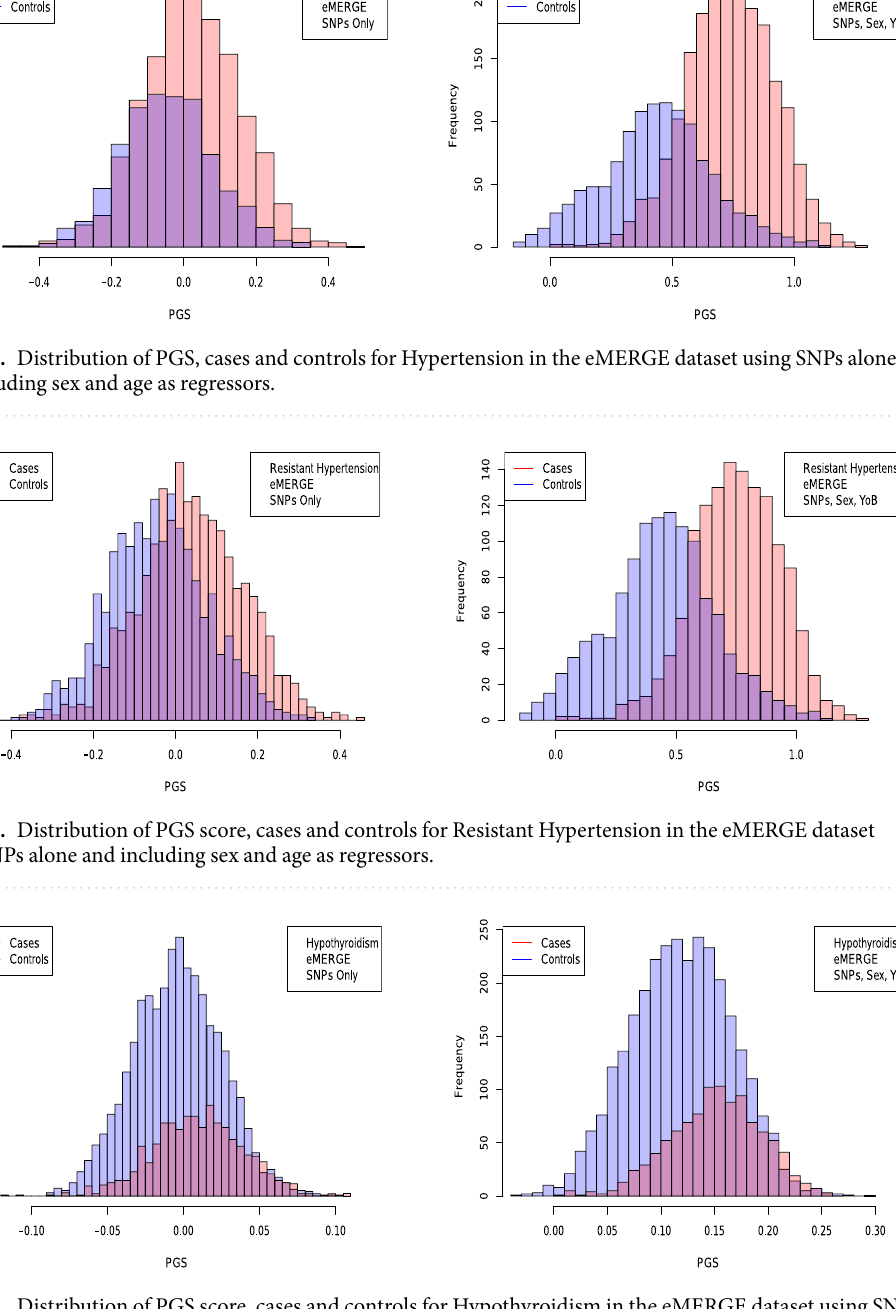
Figure 7. Distribution of PGS score, cases and controls for Hypothyroidism in the eMERGE dataset using SNPs alone and including sex and age as